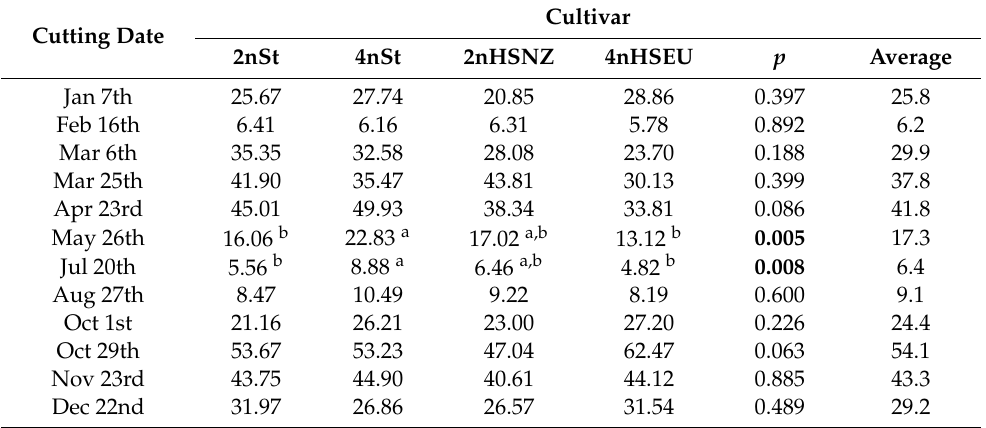
Table 2. Growth rate (kg DM ha − 1 d − 1 ) of four Lolium perenne L. cultivars under a defoliation regime of